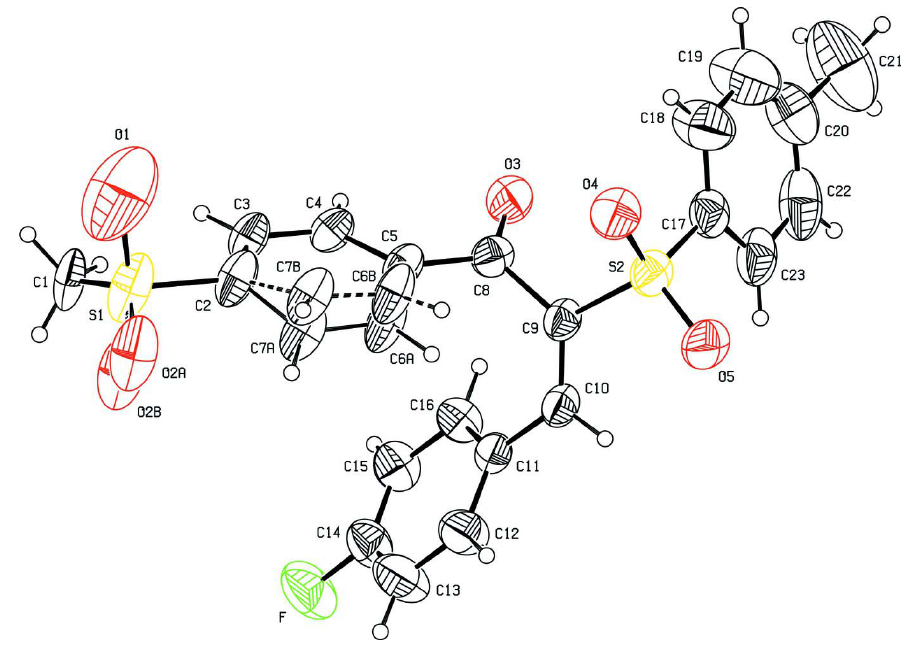
The molecular structure of title compound showing 30% probability displacement ellipsoids. The disordered components are